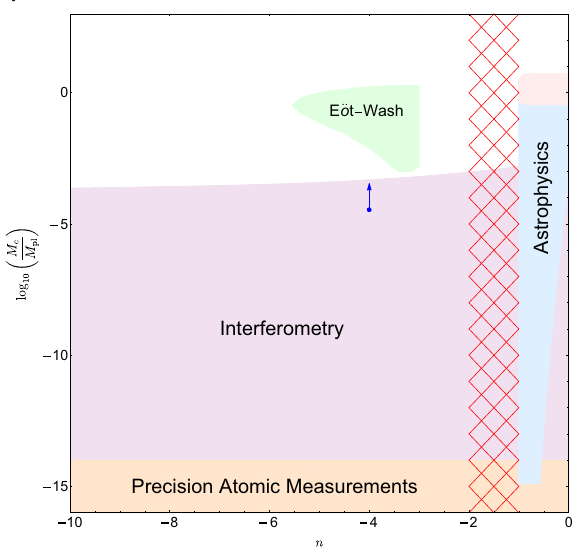
Fig. 7 Current bounds on the parameters n and M c when Λ is fixed to the dark energy scale Λ DE and n < 0. The red hashed region indicates values of n where the model is not a chameleon, and the reader is reminded that only negative even integers are chameleons. The regions excluded by each specific test are indicated in the figure; the region labelled astrophysics contains the bounds from both Cepheid and rotation curve tests. The blue arrow indicates the lower bound coming from the neutron interferometry experiment of Lemmel et al.